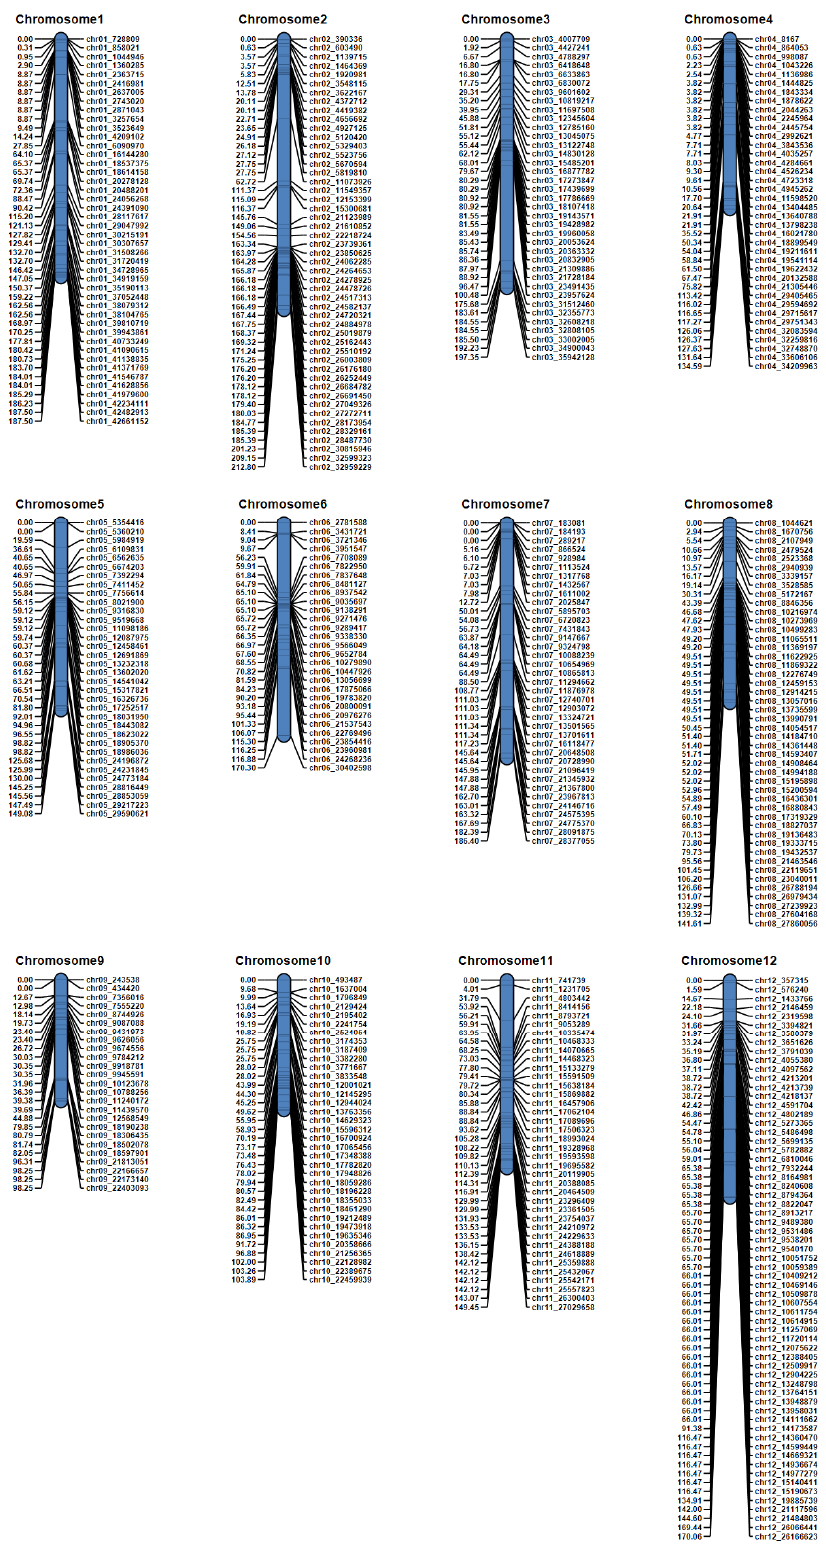
Figure 4. Construction of a genetic map using genotype data from 162 F 8 recombinant inbred lines (RILs) derived from an Odae × Joun cross obtained from the target capture panel. Chromosomes are numbered at the top. Marker names are indicated on the right-hand side of each chromosome, and the genetic distance of each marker from the first marker at the top of the chromosome is shown on the left-hand side. Genetic distances, measured in cM, were calculated using the Kosambi